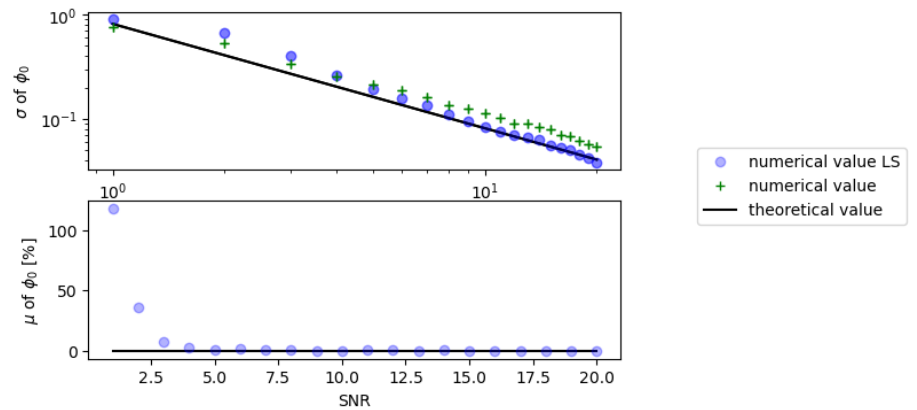
Figure 8. Bias and standard deviation of phase angle φ o . The crosses are for initial estimators obtained from the Equation(140) and the dots are for the estimators from the least-squares procedure. Continuous lines are theoretical predictions from the Fisher matrix. The standard deviation is a log-log